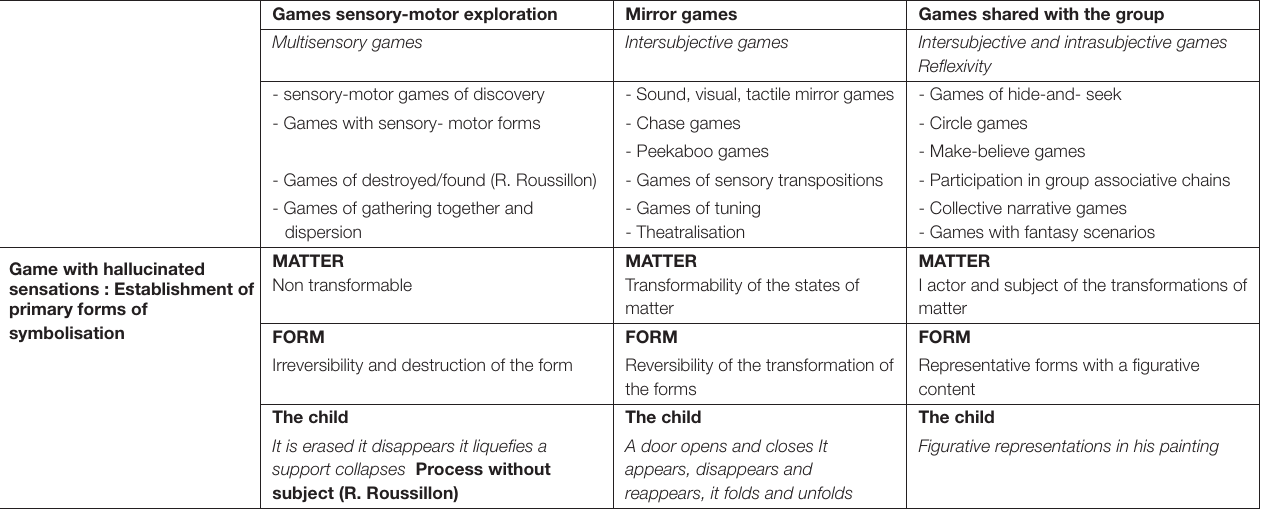
TABLE 1 | Table of games based on the clinical